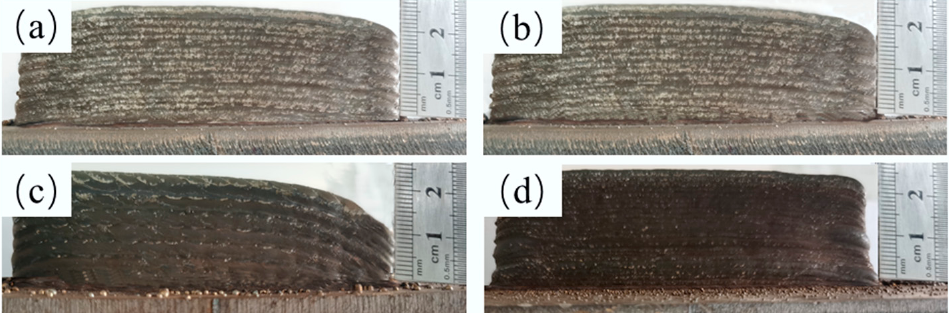
Figure 3. Macroscopic morphology of additive manufactured samples; ( a – d ) is sample 1, 2, 3, and 4, respectively.